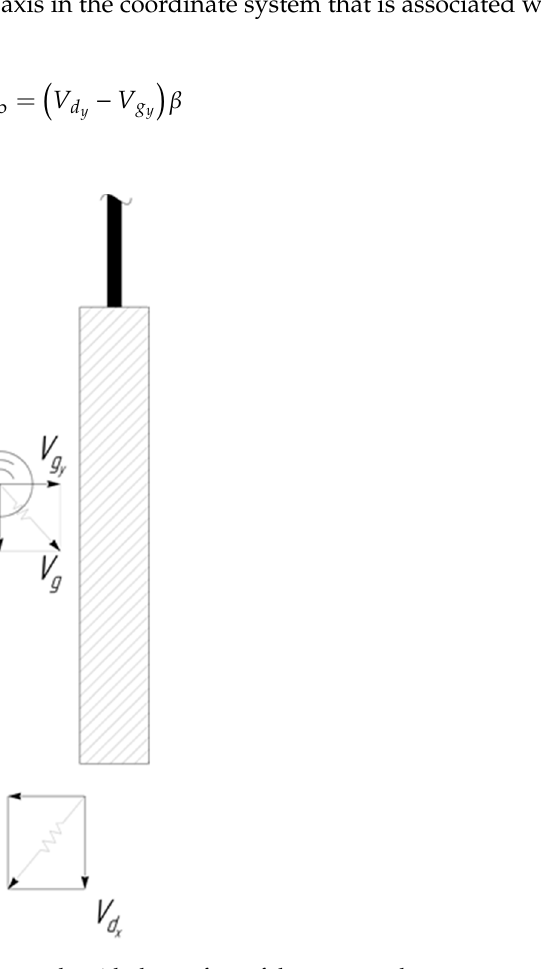
Figure 2. Collision of the moving granule with the surface of the processed part.